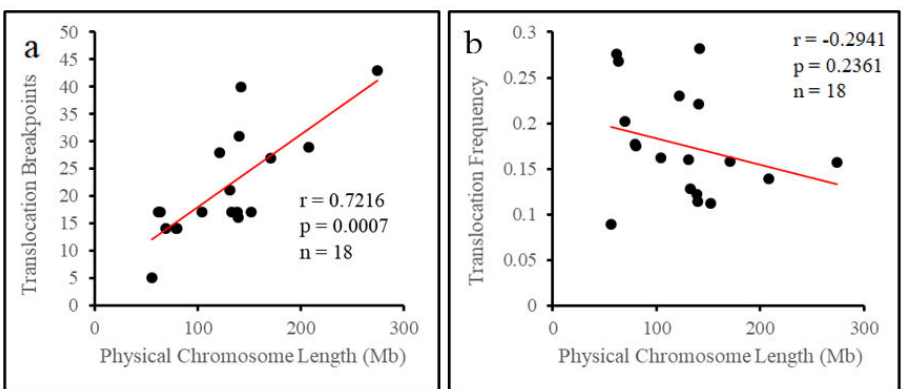
Figure 1. Physical chromosome length is associated with the number of breakpoints on chromosomes, but not the translocation frequency. ( a ) Scatterplot comparing the number of breakpoints to the physical length of each chromosome. Spearman’s correlation coe ffi cient was used to determine if there is a relationship between the two variables, r = Spearman’s correlation coe ffi cient, p = numerical representation that the result was seen by chance, n = number of chromosomes considered in the analysis. ( b ) Scatterplot comparing the translocation frequency and physical length of each chromosome. Spearman’s correlation coe ffi cient was used as described